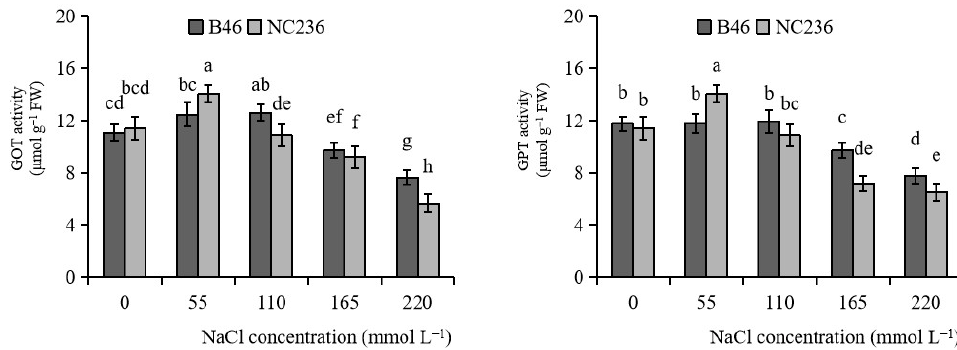
Figure 8. Effects of salt stress on the activities of GOT and GPT in maize leaves. Data are expressed as mean ± standard deviation. Different letters within the same column indicate significant difference at the 5% level.